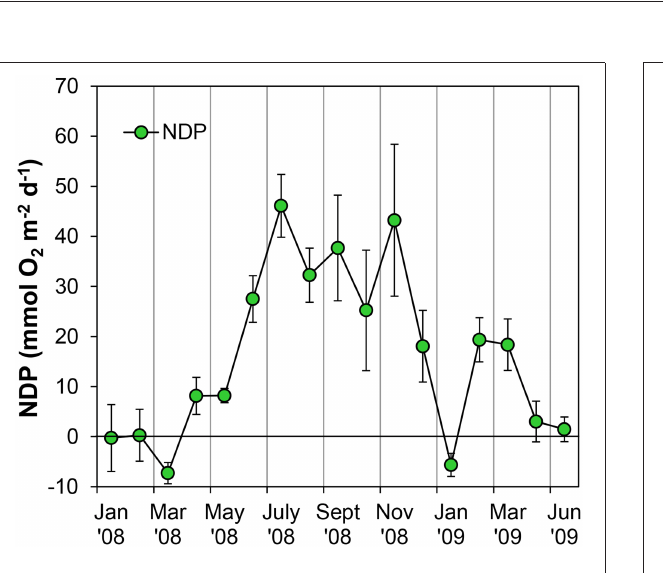
FIGURE 7 | Evolution of potential Net Daily Production (NDP) metabolism measured as Oxygen flux at the sediment-water interface using oxygen microsensors at the sampling station on Trocadero Island, Bay of Cádiz, from January 2008 to June 2009. Data are mean of 4–6 sediment cores ± SD.